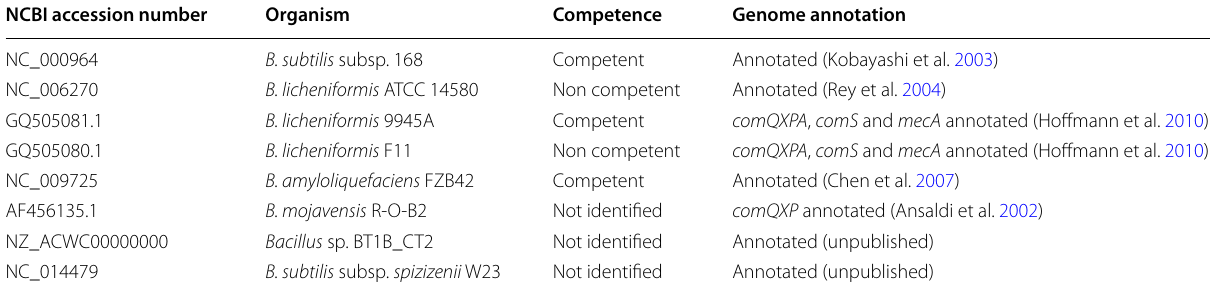
Table 1 Bacillus species used for comparative analysis to QS-related genes in B. licheniformis NCIMB